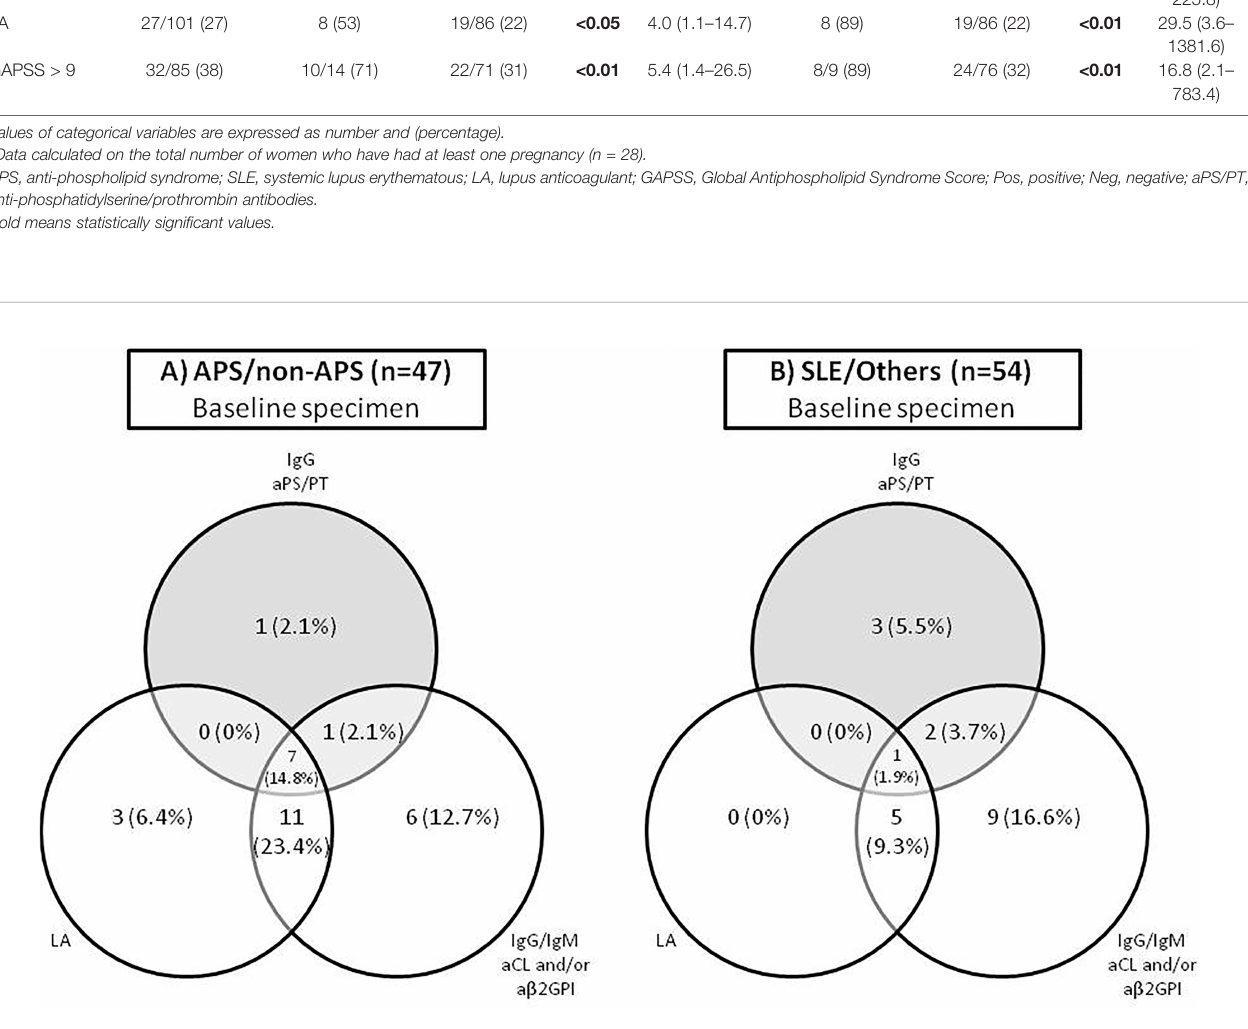
FIGURE 1 | The distribution of aPL biomarker reactivity in (A) APS/non-APS samples and (B) SLE/Others